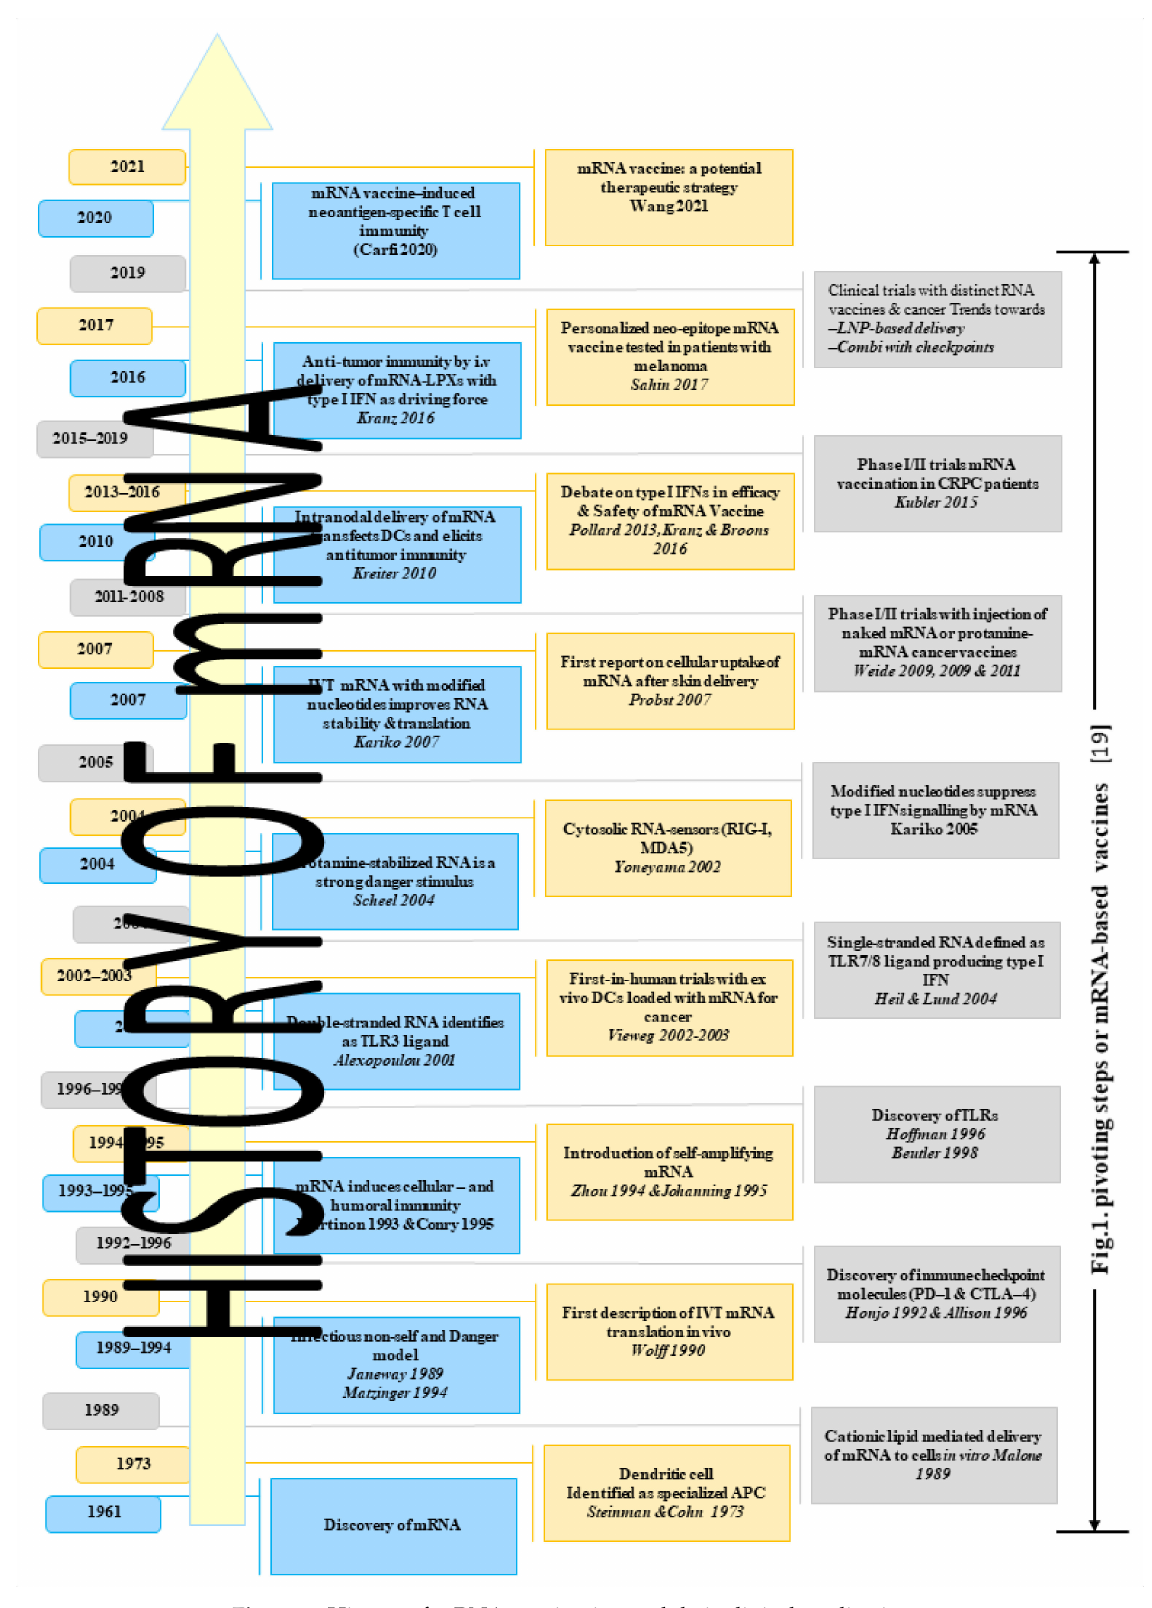
Figure 1. History of mRNA vaccination and their clinical